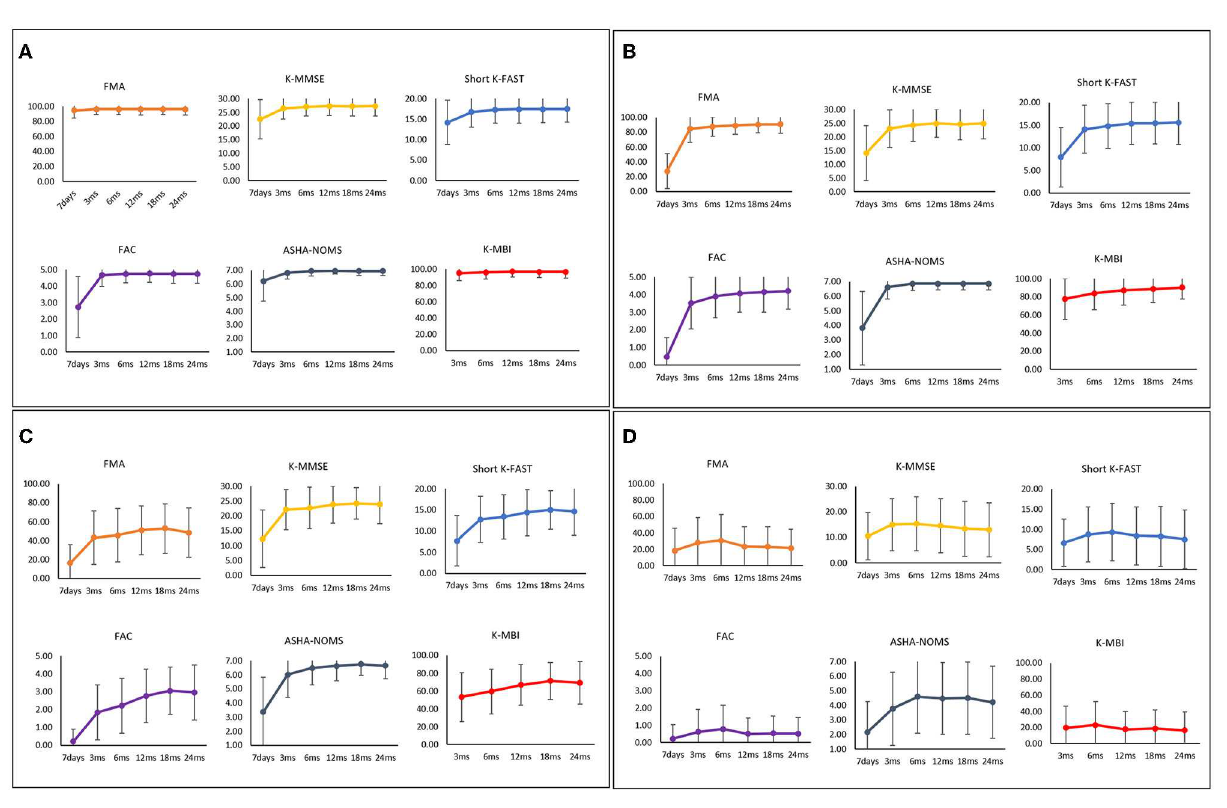
FIGURE4 Functional recovery patterns of clusters of hemorrhagic stroke patients until 24 months after onset. (A) Cluster 1 ( n = 710); minimal functional deficit in all domains, (B) Cluster 2 ( n = 208); early rapid recovery of all functions, (C) Cluster 3 ( n = 128); significant improvement in all domains over 24 months after stroke with lower motor and ambulatory function, (D) Cluster 4 ( n = 100); severe dysfunctions in all domains. FMA, Fugl-Meyer Assessment; FAC, Functional Ambulatory Category; K-MMSE, Korean Mini-Mental State Examination; Short K-FAST, Short Korean version of the